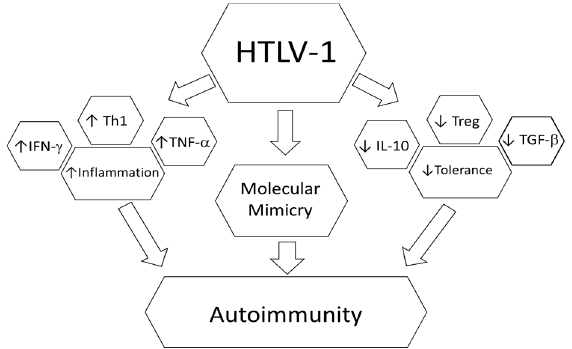
Figure 1. Possible mechanisms involved in HTLV-1 association with autoimmunity.